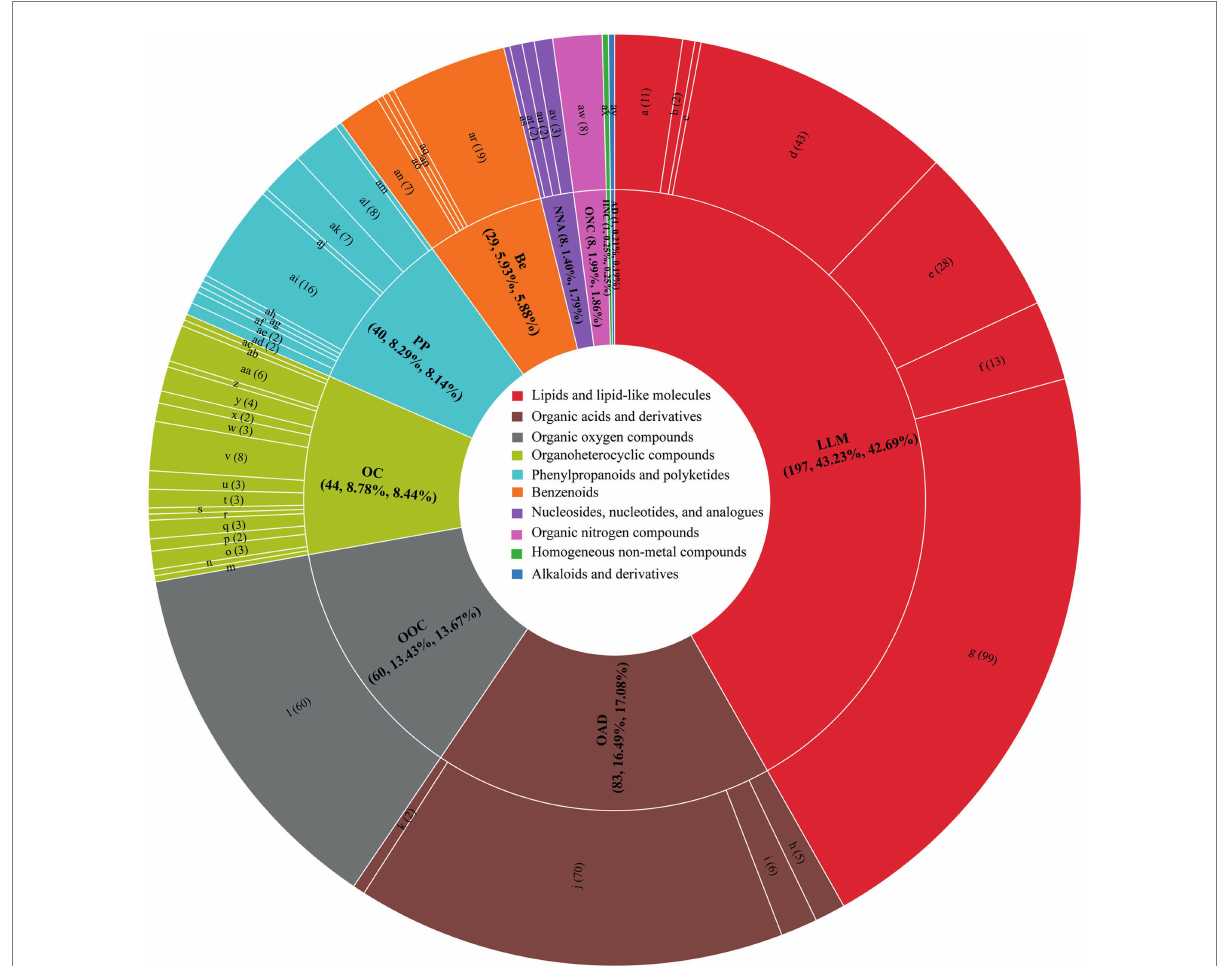
FIGURE 4 Sunburst of the contribution of nVFCs in SF3 and CK3 in OPLS-DA. a, steroids and steroid derivatives; b, sphingolipids; c, saccharolipids; d, prenol lipids; e, glycerophospholipids; f, glycerolipids; g, fatty Acyls; H, keto acids and derivatives; i, hydroxy acids and derivatives; j, carboxylic acids and derivatives; k, carboximidic acids and derivatives; l, Organooxygen compounds; m, pyrrolidines; n, pyrroles; o, pyridines and derivatives; p, pyrans; q, pteridines and derivatives; r, oxepanes; s, naphthofurans; t, lactones; u, indoles and derivatives; v, imidazopyrimidines; w, heteroaromatic compounds; x, dihydrofurans; y, diazines; z, benzotriazoles; aa, benzopyrans; ab, benzodioxoles; ac, azolidines; ad, stilbenes; ae, phenylpropanoic acids; af, macrolides and analogs; ag, Kavalactones; ah, isoflavonoids; ai, flavonoids; aj, diarylheptanoids; ak, coumarins and derivatives; al, cinnamic acids and derivatives; am, 2-arylbenzofuran flavonoids; an, phenols; ao, phenol ethers; ap, phenanthrenes and derivatives; aq, naphthalenes; ar, benzene and substituted derivatives; as, ribonucleoside 3 ′ -phosphates; at, pyrimidine nucleotides; au, pyrimidine nucleosides; av., pyrimidine nucleosides; aw, organonitrogen compounds; ax, non-metal oxoanionic compounds; ay,